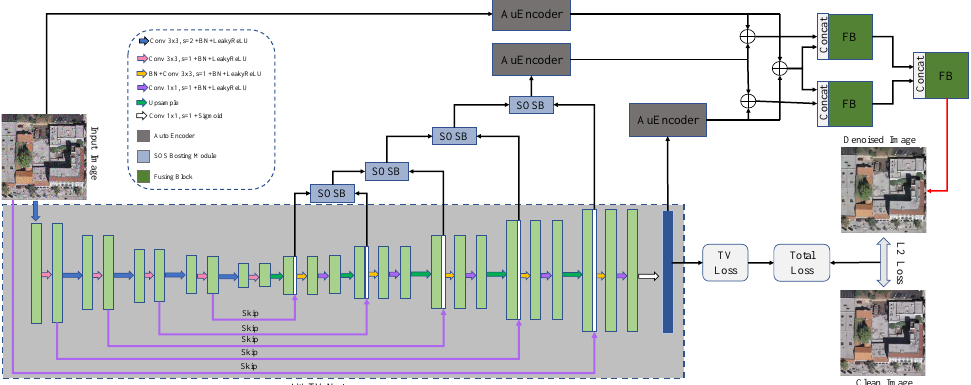
Figure 4. Network architecture of the proposed AWTV F 2 Net. In this framework, the light green rectangles denote the middle features of the AWTV-Net module. The blue rectangle is the final output feature from AWTV-Net. The white rectangles are the skip feature maps. The thick, different- colored arrows indicate convolutional operators with different kernel sizes and strides, described in the middle dot-line rectangle. The black arrows denote the directions of data flowing. The SOSB rectangles are the feature map boosting modules, and AuEncoder rectangles are the modules extracting features from multi-inputs, ⊕ denote additive operator. FB rectangles indicate the feature fusion modules. The red arrow marks the process of image reconstruction. The loss rectangles represent different loss